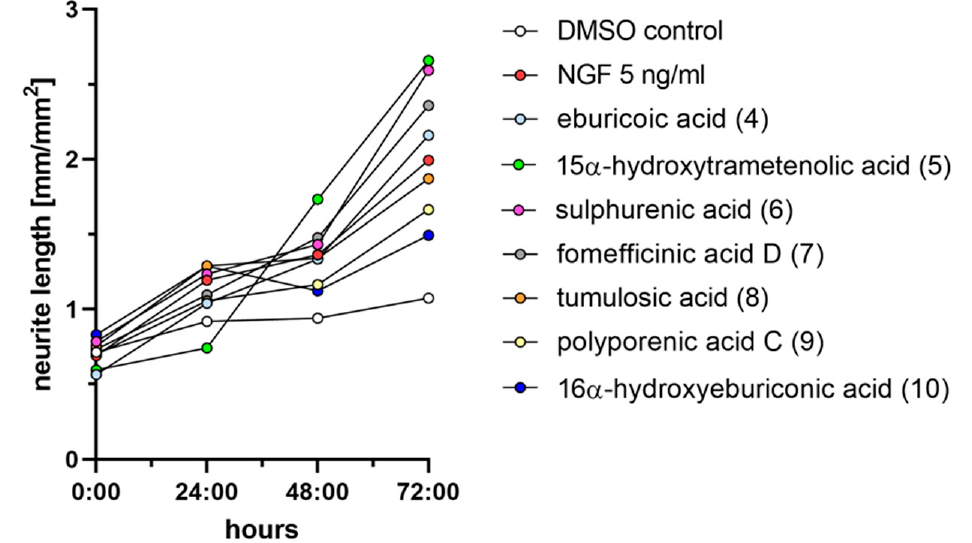
Figure 3. Graph showing the mean neurite length of PC-12 cells treated with different triterpenes supplemented with 5 ng/mL ngf over a time period of 72 h. Negative control is PC-12 cell treated with 0.5% DMSO. Positive control is 5 ng/mL ngf.